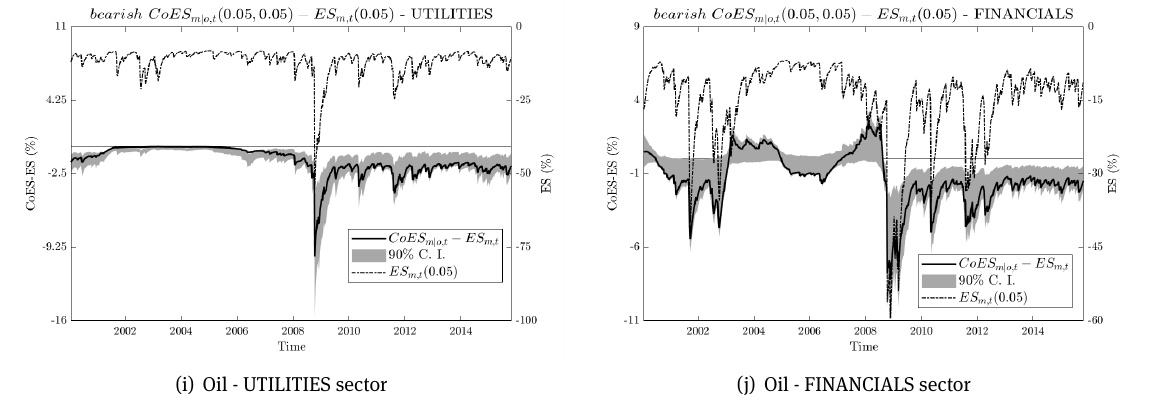
(i) Oil - UTILITIES sector (j) Oil - FINANCIALS sector